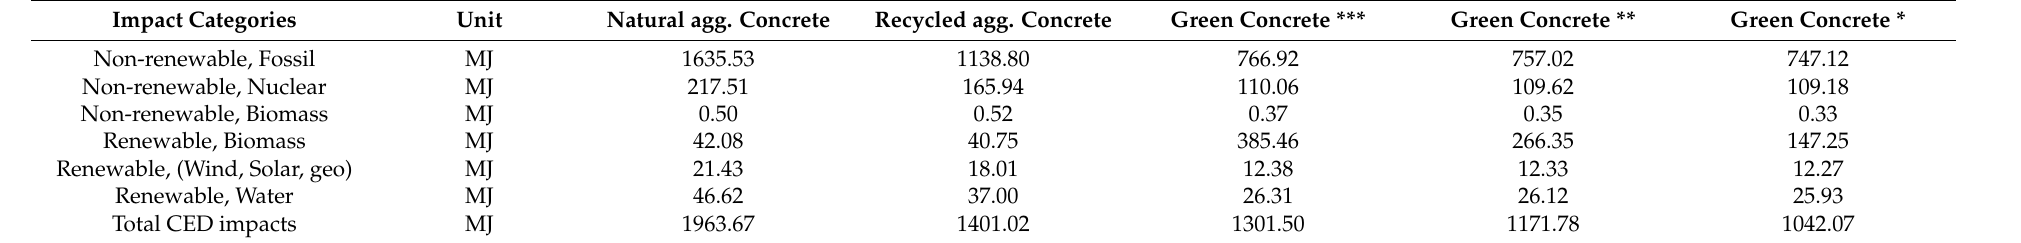
Table 7. Energy characterized CED impacts for production of 1 m 3 of conventional, recycled and green concretes